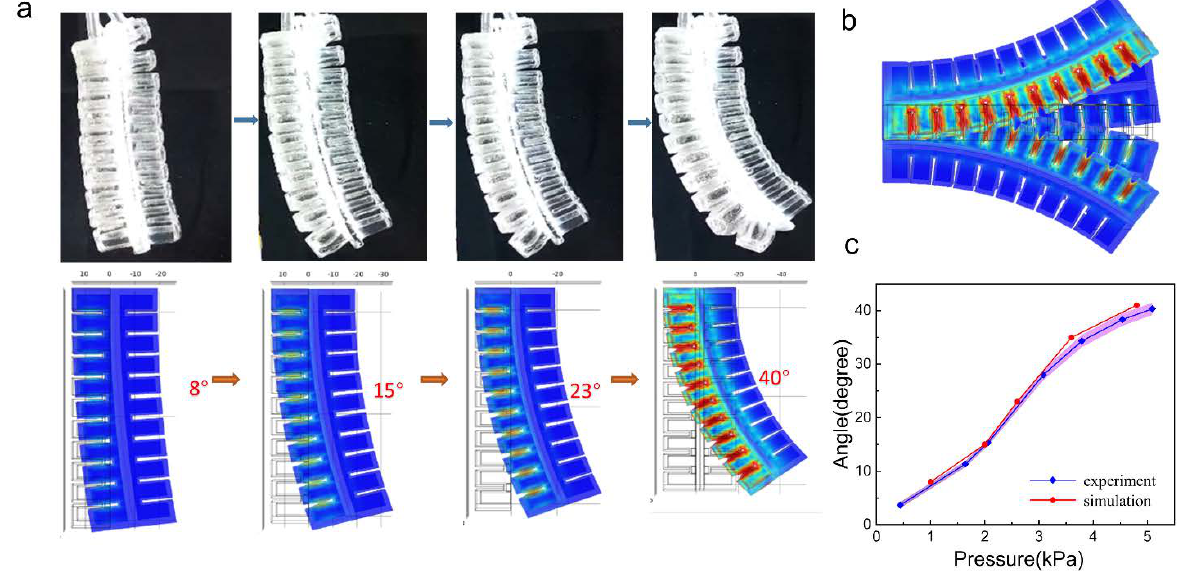
Figure 3. ( a ) The bending effect of the actuator at different angles in experiments and simulations. ( b ) Simulated effects of the actuator bending bidirectionally. ( c ) The bending angles of the actuator under different pressures in experiments and simulations.